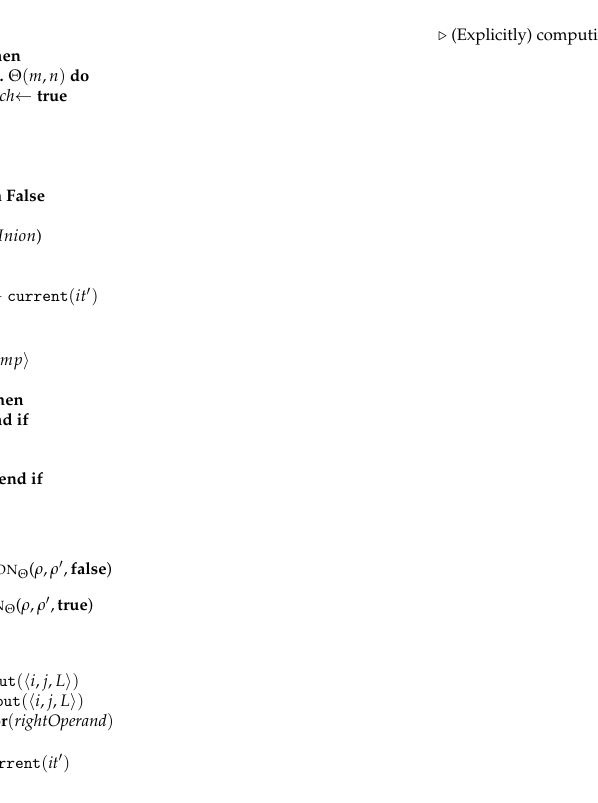
Algorithm 7 xt LTL f pseudocode implementation for And Θ and Or Θ